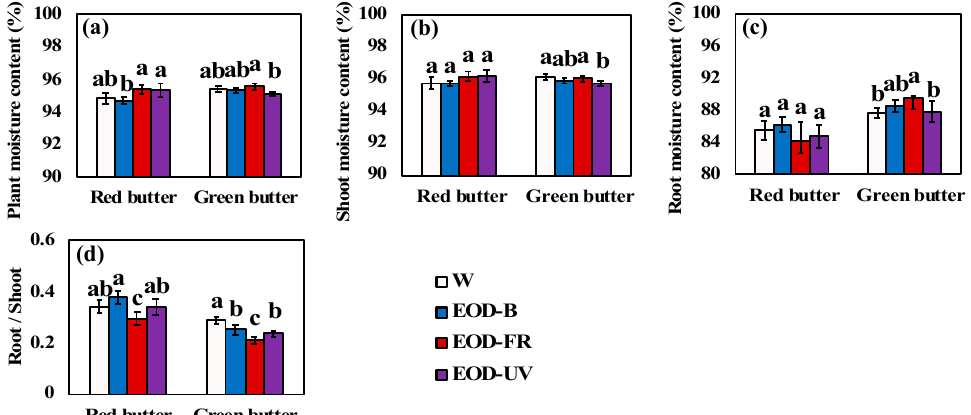
Figure 4. Moisture content and root–shoot ratio of lettuce under different end-of-day lightings. Moisture content of plant ( a ), shoot ( b ) and root ( c ). ( d ) was the root–shoot ratio. Different letters on the top of the columns indicate significant differences at p < 0.05 according to one-way ANOVA, Tukey’s honest significant difference tests. W= day-white light, EOD-B = end-of-day enhanced blue light, EOD-FR = end-of-day far-red light, EOD-UV = end-of-day ultraviolet-A light. Table 3. The interaction effects of cultivars and lightings on lettuce moisture content and root–shoot ratio. Interaction Moisture Content Interaction Root/Shoot Plant Shoot